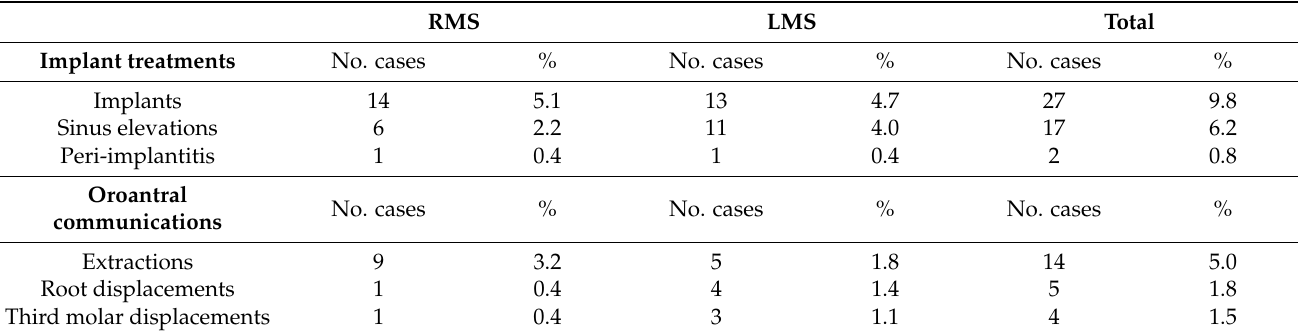
Table 2. Distribution of implant treatments and of the causes of oroantral communications by number of cases and percentages.